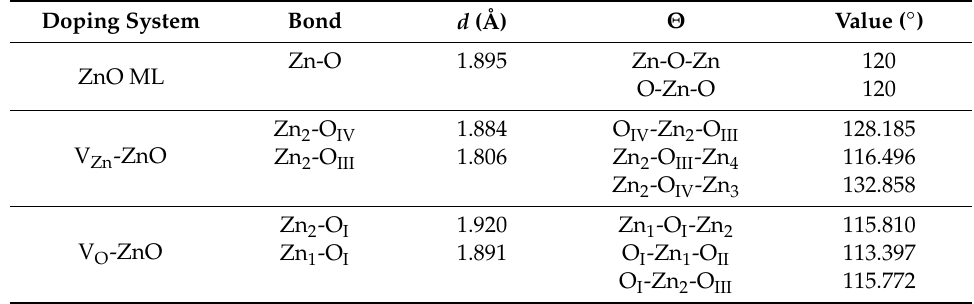
Table 1. Bond length d and bond angle θ of ZnO ML, V Zn -ZnO, and V O -ZnO (the atomic number is labeled in Figure